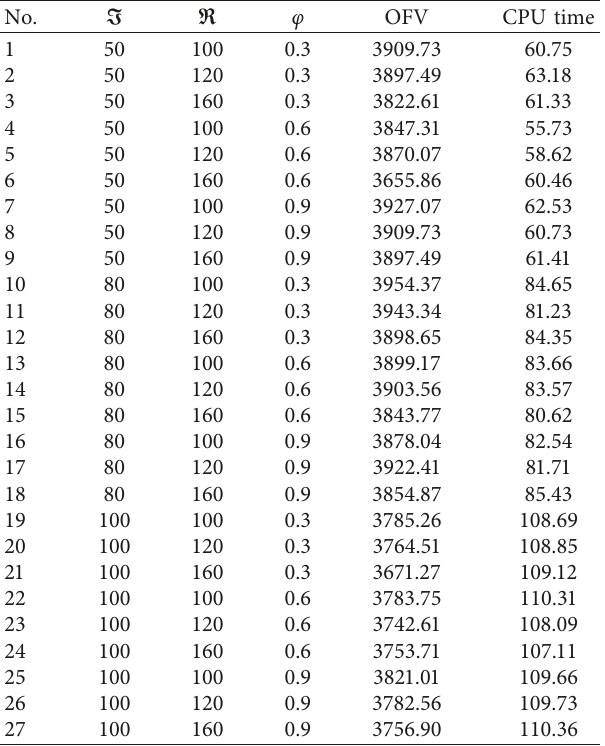
Table 5: Testing results of parameter combination. No.